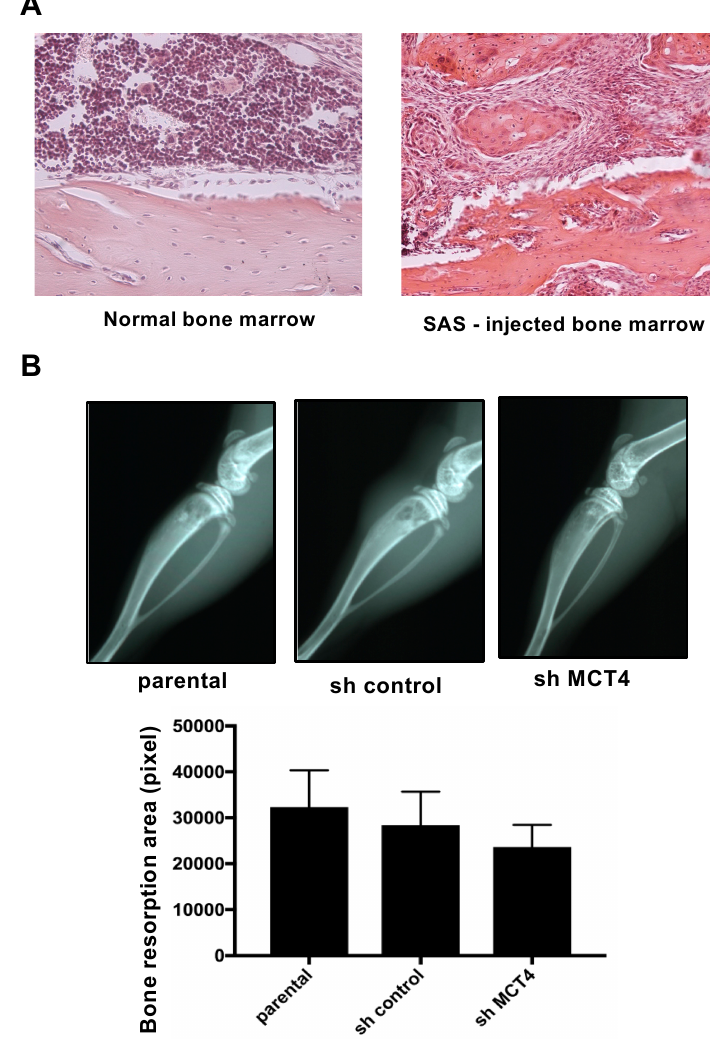
Figure 4. Bone resorption of the tibia in SAS cell-injected mice. ( A ) Normal bone marrow tissue and SAS cells colonized in bone marrow (hematoxylin and eosin) at 100 × magnification. ( B ) X-ray photographs showing bone resorptions of the tibia at post-operative day (POD) seven in SAS cell-injected mice. The lower panel compares the bone resorption areas. There was no significant difference between the parental and sh-MCT4 groups ( n = 5). Error bars: mean ± SD.